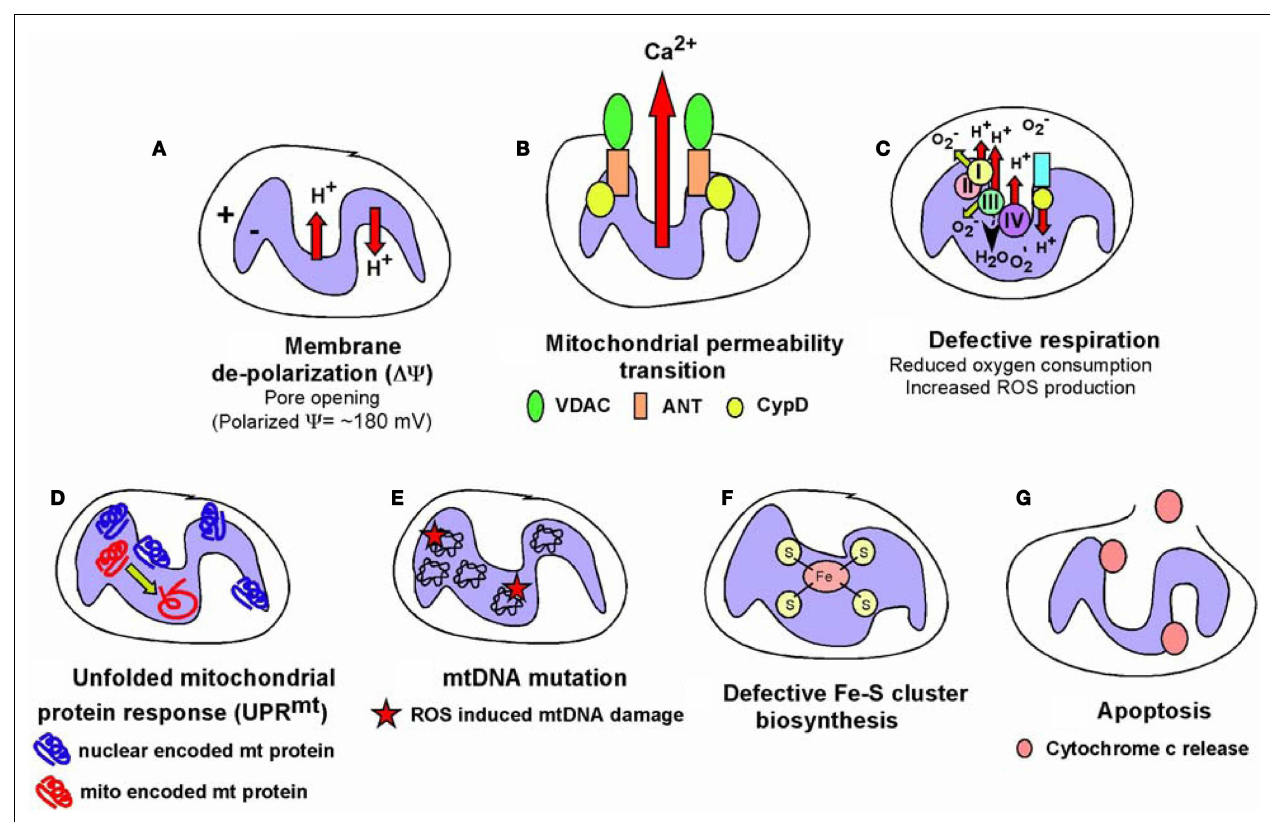
mitochondria; (E) damage to the mitochondrial genome most commonly reported as a result of oxidative damage to bases arising from respiratory chain defects; (F) defects in the production of iron-sulfur complexes in the mitochondrial matrix leading to defects not just in respiratory chain components but also other cellular enzymes; (G) release of cytochrome c anchored at the inner mitochondrial membrane via cardiolipin can result in formation of the apoptosome and activation of caspases leading to apoptosis. Some of these aberrant mitochondrial behaviors are inter-dependent, for example, membrane depolarization is a factor in mitochondrial permeability transition, defective respiration, and apoptosis amongst other consequences, but frequently can stand alone as a signal, for example to promote mitophagy. The consequences for the cell of these different forms of mitochondrial dysfunction are described in the text and below in Figure 7